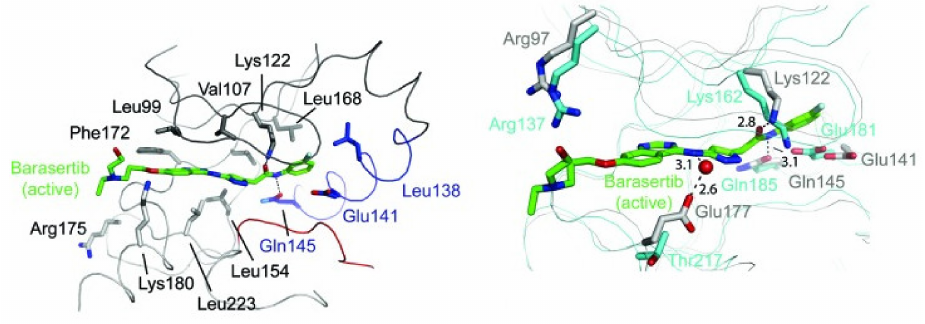
Figure 16. Binding interactions of compound 5 with Aurora B crystal structure